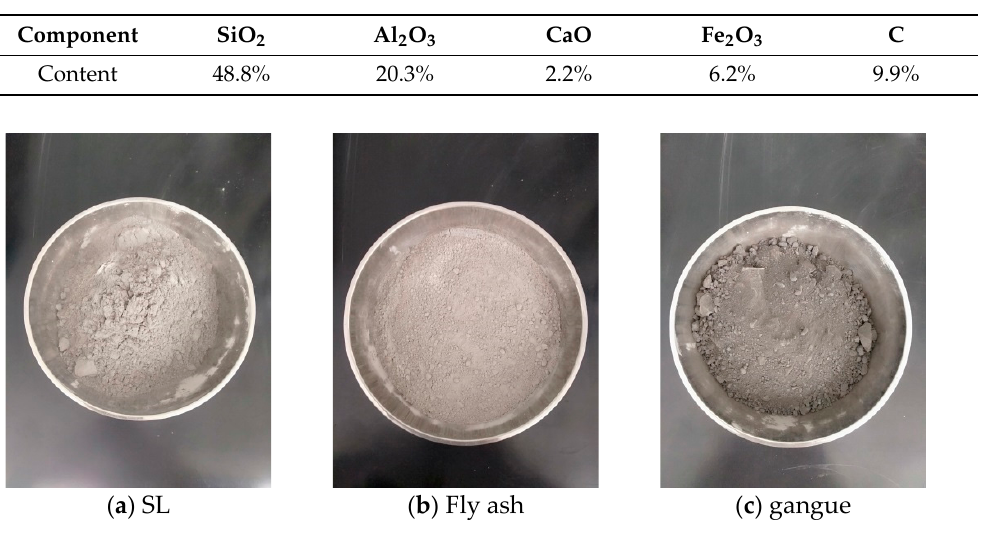
Figure 1. The raw materials. Table 2. Physical properties of SL cement.